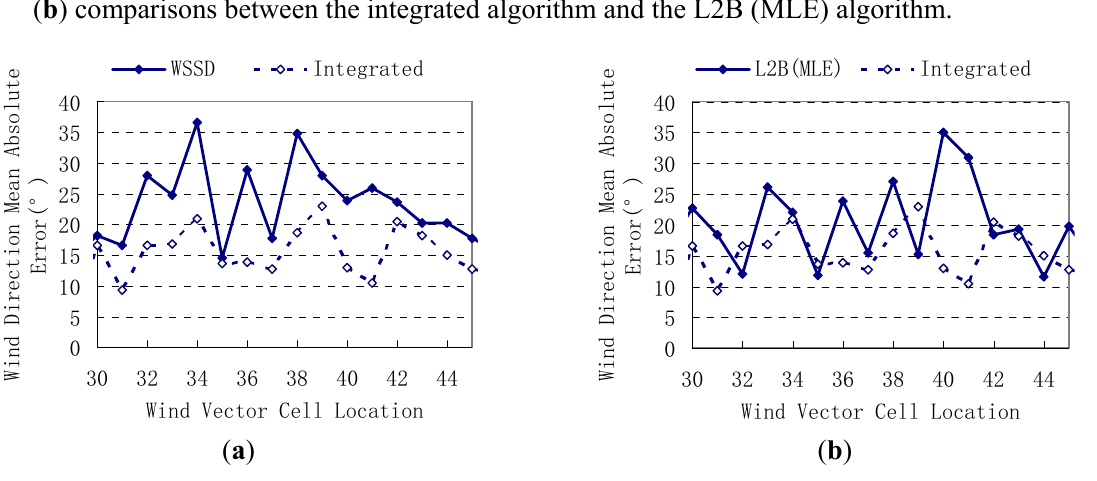
Figure 5. The wind direction errors at each wind vector cell location in the nadir region: ( a ) comparisons between the traditional WSSD and the integrated algorithm and ( b ) comparisons between the integrated algorithm and the L2B (MLE)